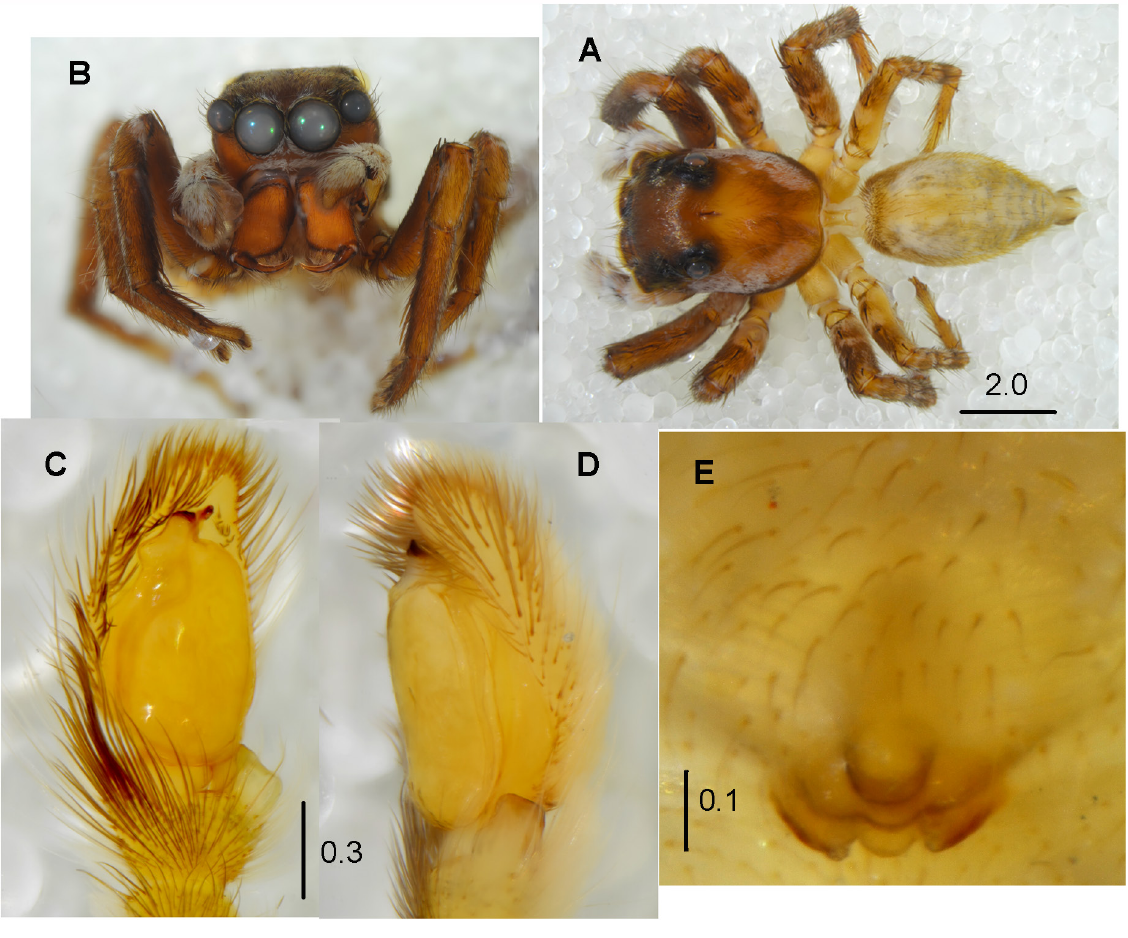
Fig. 68. Thiratoscirtus tentativus (Szűts & Jocqué, 2001), ♂♀ (MNHN). A . Habitus of male, dorsal view. B . Frontal view of male. C . Palpal organ, ventral view. D . Palpal organ, lateral view. D .